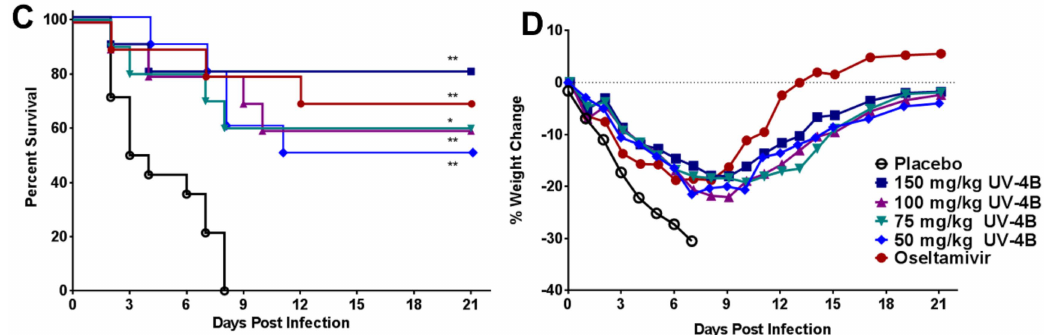
Figure 3. Antiviral efficacy of UV-4B in lethal mouse models of influenza A (H1N1) virus infections. Female BALB/c mice were infected with ~1LD 90 of influenza virus via intranasal instillation. Mice were administered UV-4B diluted in sterile water. The dose levels are expressed as the active free base form, UV-4. Mice ( n = 10/group) were orally treated with 50, 75, 100 or 150 mg/kg/dose of UV-4, vehicle or oseltamivir starting one hour before infection. Efficacy data are plotted as percent survival against days post virus exposure. Average weight changes per group are plotted versus days post virus exposure. ( A , B ) UV-4 efficacy following infection with influenza A/CA/04/09 (H1N1pdm09). In this study, UV-4 was administered for 10 days and oseltamivir was administered at 20 mg/kg/dose BID for 5 days. Mice were monitored for through 14 days post infection. ( C , D ) UV-4 efficacy following infection with influenza A/New Caledonia/99 (H1N1). In this study, UV-4 was administered for 7 days and oseltamivir was administered at 10 mg/kg/dose TID for 5 days. Mice were monitored for through 21 days post infection. * p < 0.01, ** p < 0.001, *** p <